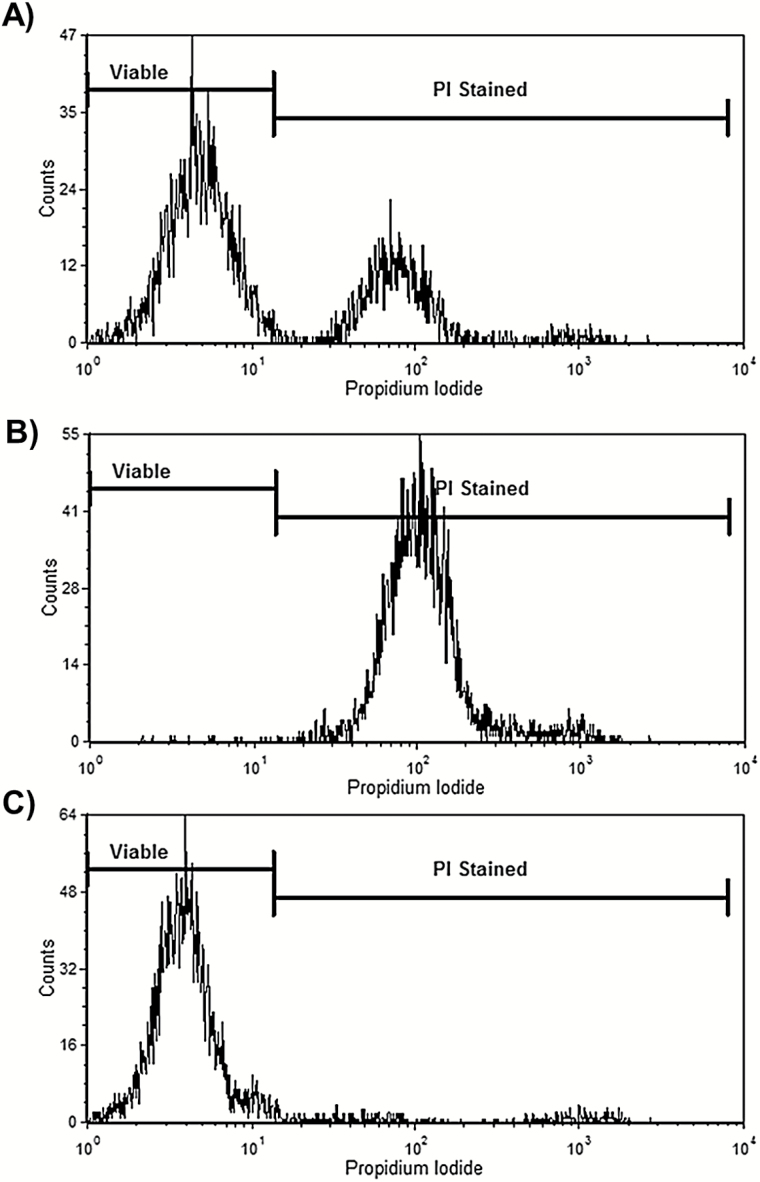
FCM analysis of human lymphoblastoid cells (TK6) following aerolysin and PI treatment. Flow cytometric outputs following consecutive aerolysin and PI treatment on parental TK6 strain (A) and FACS enriched CD59 positive (B) and negative populations (C).